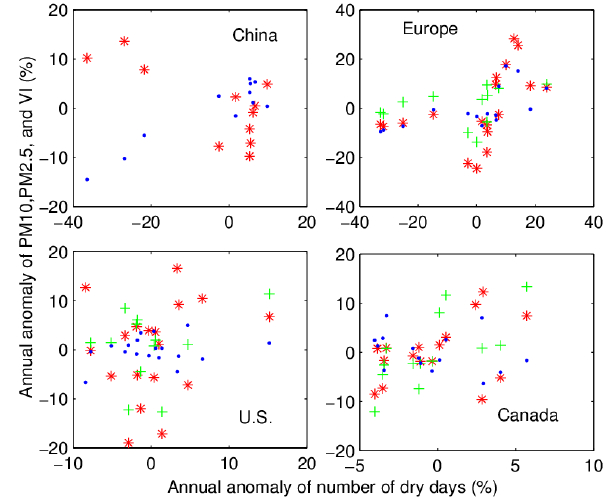
Figure 10. Scatterplots of regional averaged annual anomalies of PM10 (red star), Fig. 10. Scatterplots of regional averaged annual anomalies of PM2.5 (green cross), and aerosol optical extinction (inverse of visibility, blue dot) PM 10 (red star), PM 2 . 5 (green cross), and aerosol optical extinction as a function of annual anomaly of number of dry days in China, Europe, the U.S., (inverse of visibility, blue dot) as a function of annual anomalies and Canada. Data used are same to Fig. 4 and 6. The correlation coefficients of number of dry days in China, Europe, the US, and Canada. Data between optical extinction and dry days are 0.93 (China), 0.66 (Europe), 0.23 (the used are same to Fig. 9. The correlation coefficients between optical U.S.) and -0.32 (Canada). The correlation coefficients between PM10 and dry extinction and dry days are 0.93 (China), 0.66 (Europe), 0.23 (the days are -0.73 (China), 0.47 (Europe), 0.20 (the U.S.) and 0.42 (Canada). The US) and -0.32 (Canada). The correlation coefficients between PM 10 and dry days are − 0.73 (China), 0.47 (Europe), 0.20 (the US) and 0.42 (Canada). The correlation coefficients between PM 2 . 5 and dry days are 0.29 (Europe), 0.29 (the US) and 0.68 (Canada).